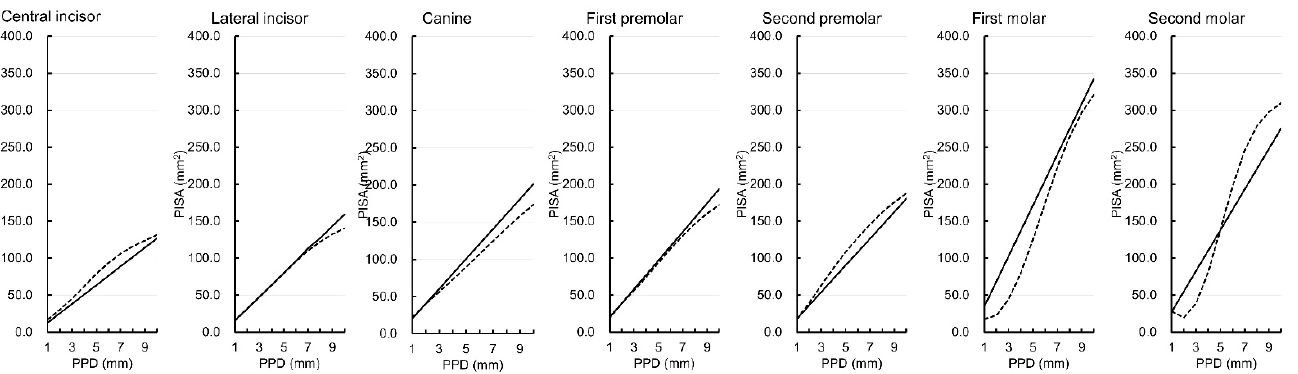
5 of 9 Figure 1. Simulated periodontal epithelial surface area (PISA) for probing pocket depths (PPDs) of